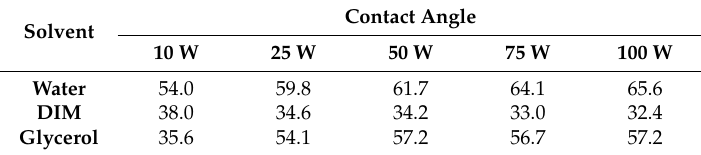
Table 5. Contact angles θ for geranium oil-derived thin polymer films deposited at varied RF